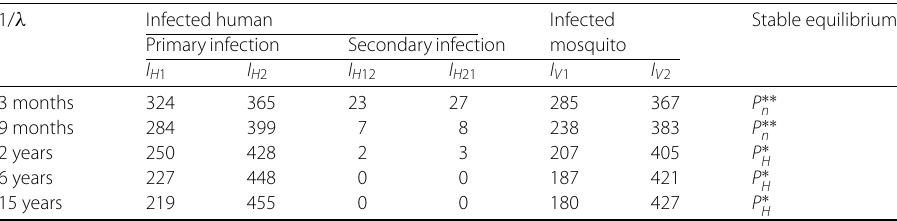
Table 3 Effect of the period of cross immunity (1/ λ ) on the number of infected populations: I H 1 , I H 2 , I H 12 , I H 21 , I V 1 , and I V 2 at steady state using the multi-serotype dengue model (2.4)–(2.5) 1/ λ Infected human Infected Stable equilibrium mosquito Primaryinfection Secondaryinfection I H